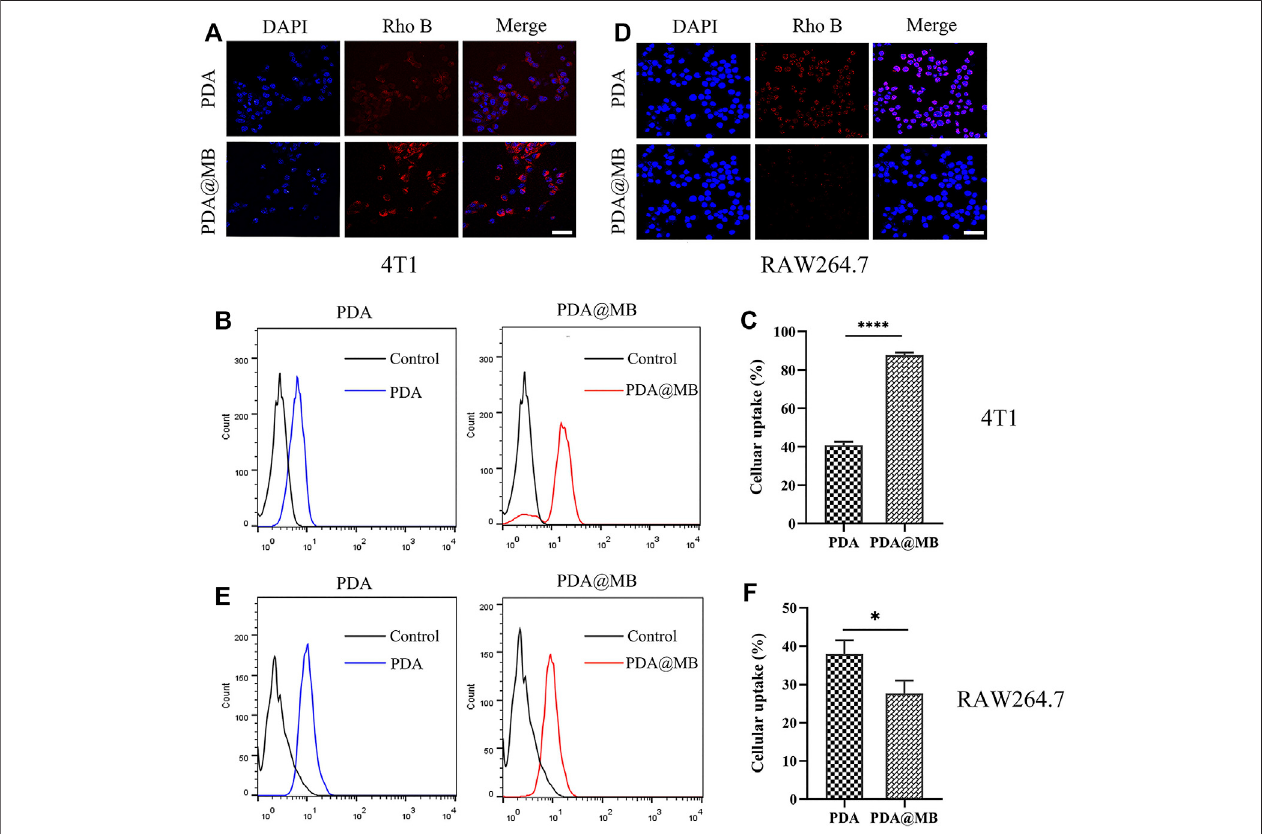
FIGURE3|(A) CLSMimages of4T1cellsincubated withPDAand PDA@MB.Thescalebar is50 μ m. (B) Flowcytometric pro fi lesof4T1cells incubated withPDA and PDA@MB for 1 h. (C) The uptake ef fi ciency of PDA and PDA@MB in 4T1 cells. (D) CLSM images of RAW264.7 cells incubated with PDA and PDA@MB. The scale bar is 50 μ m. (E) Flow cytometric pro fi les of RAW264.7 cells incubated with PDA and PDA@MB for 1 h. (F) The uptake ef fi ciency of PDA and PDA@MB in RAW264.7 cells. Data are represented as mean ± SD ( n = 3, p p < .05; pp p < .01; ppp p < .001; pppp p <